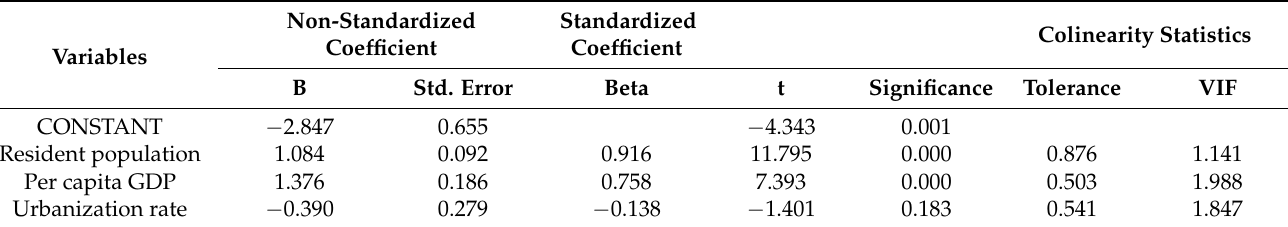
Table 7. Model test results of Nanchang metropolitan area.